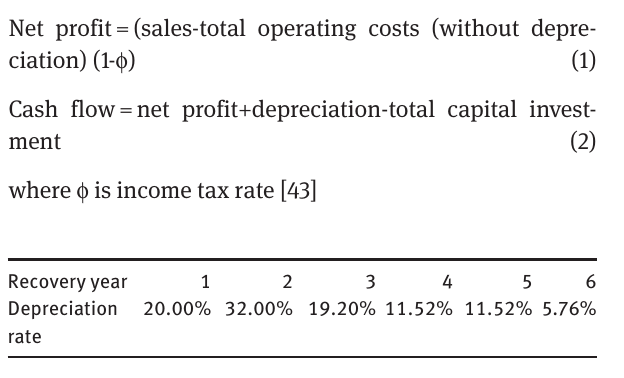
Table 5 Annual depreciation rates with modified accelerated cost recovery system (MACRS) depreciation method 5-year recovery period.